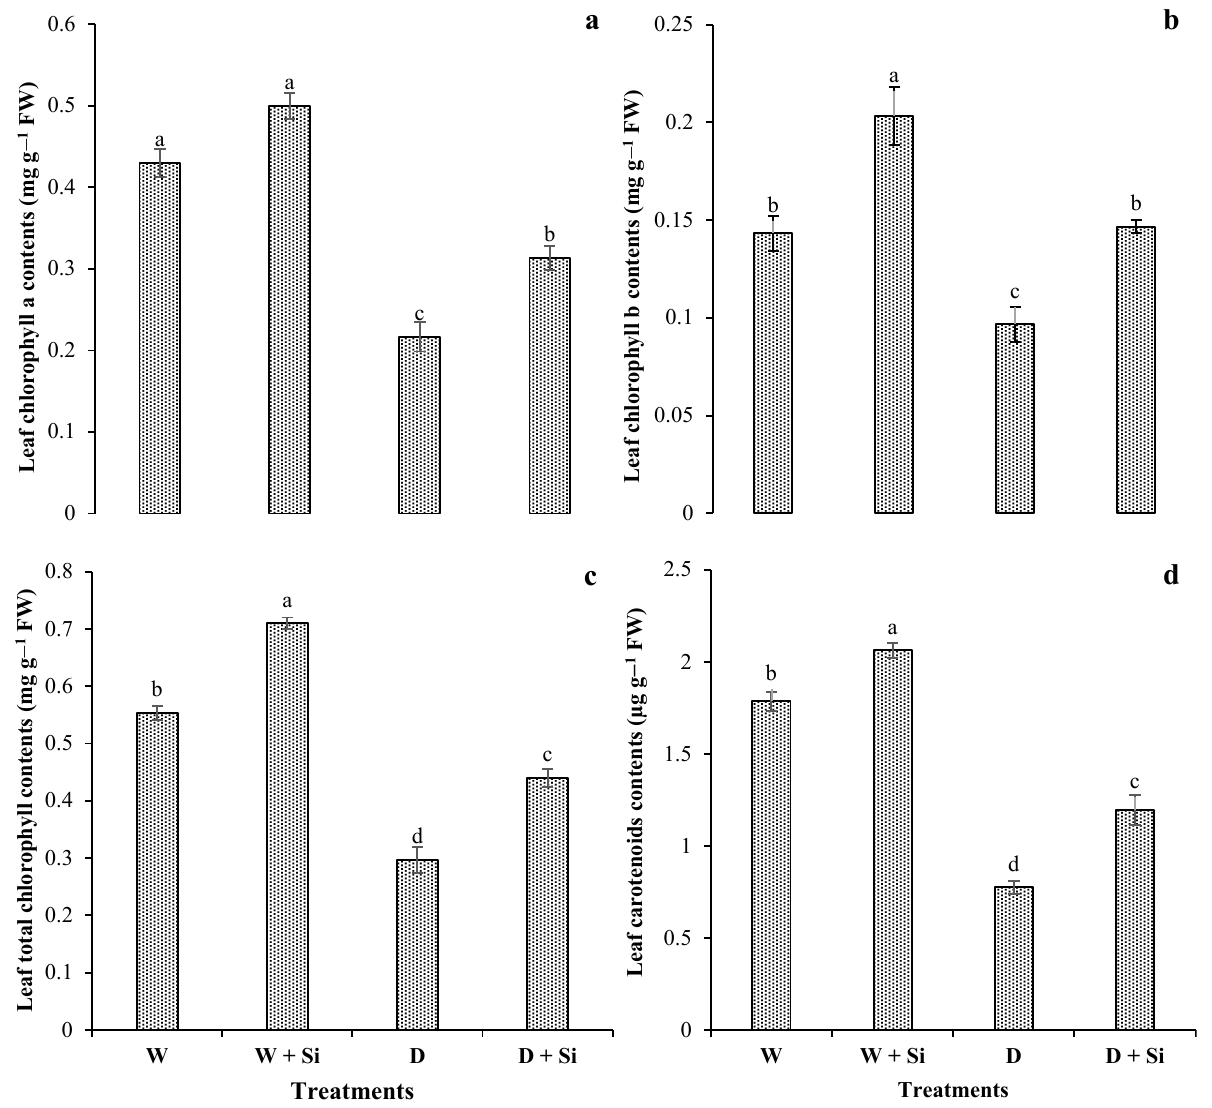
Figure 3. Impact of foliar Si supplementation on leaf photosynthetic pigments, chlorophyll a ( a ), chlorophyll b ( b ), total chlorophyll ( c ), and carotenoid contents ( d ) of Gerbera jamesonii under water- deficient conditions. Each bar shows a mean of four replicates ± SE. Dissimilar lettering illustrates significant statistical differences at p ≤ 0.05 after applying LSD test.